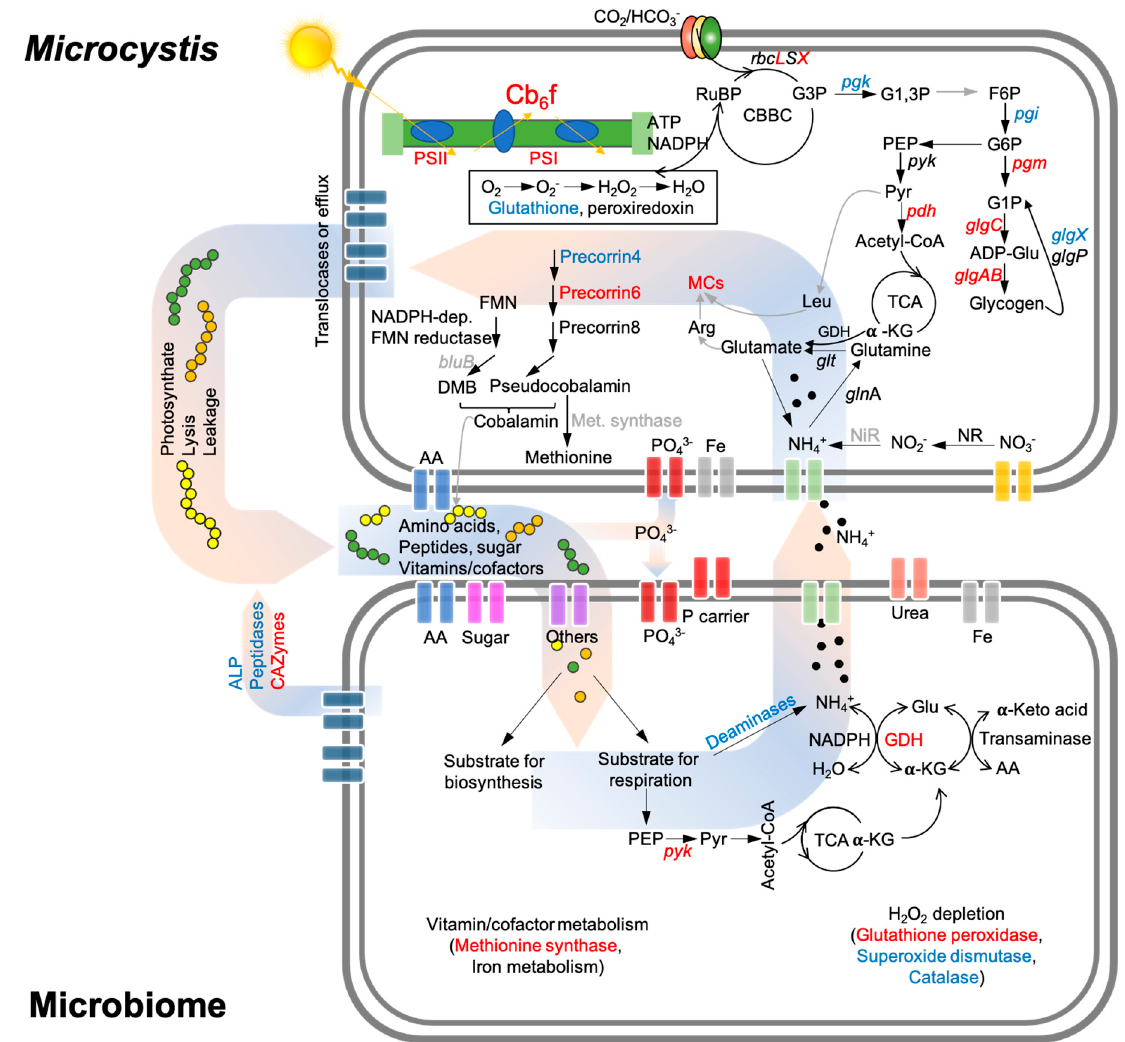
Figure 6. A schematic diagram showing the potential interactions between Microcystis and its microbiome communities. AA—amino acids; ALP—alkaline phosphatase; CAZymes—carbohydrate-active enzymes; TCA—tricarboxylic acid cycle; NR —nitrate reductase; NiR —nitrite reductase; Gln—glutamine; Glu—glutamate; glnA —glutamine synthase; glt genes— glutamate synthases; GDH—glutamate dehydrogenase; α -KG—alpha-Ketoglutarate; MCs—microcystins; Arg—arginine; Leu—Leucine; glgABC —glycogen synthesis; glgP —glycogen degradation; glgX —Glycogen debranching enzyme; pgi — glucose-6-phosphate isomerase; pgk —phosphoglycerate kinase; pgm —phosphoglucomutase; pdh —pyruvate dehydrogenase; pyk —pyruvate kinase. The genes that peaked in the daytime and nighttime are in red and blue, respectively.